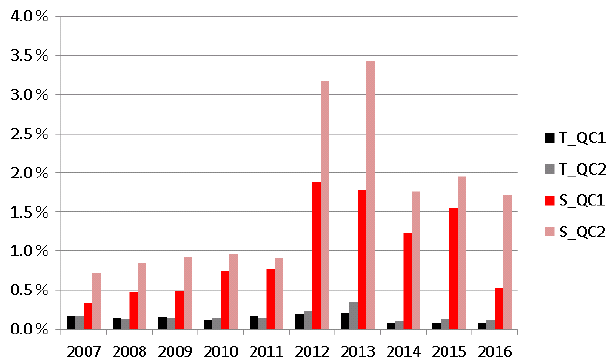
Figure 4. Statistics of suspicious temperature ( T ) and salinity ( S ) detected by QC1 ( T _QC1 and S _QC1) and by QC2 ( T _QC2 and S _QC2) quality controls as a function of year in the PSY4V3 2007– 2016 simulation time